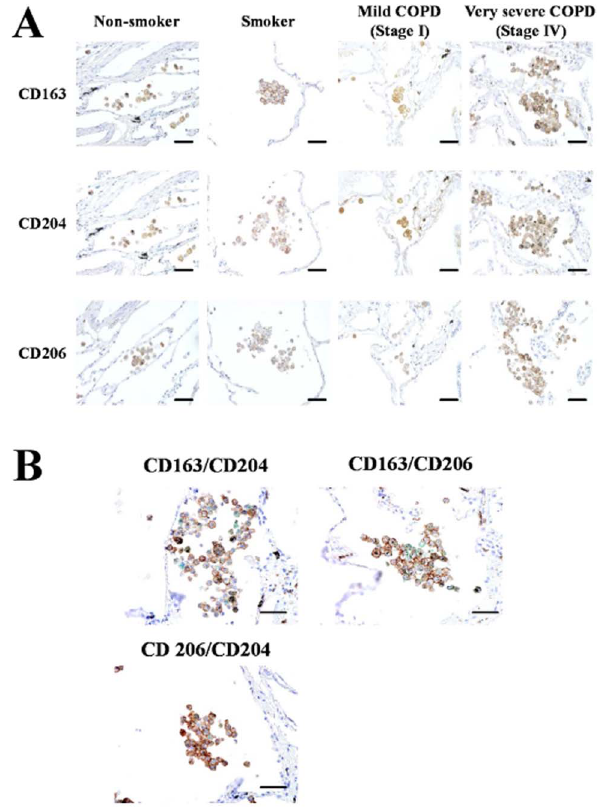
Figure 3. CD163, CD204 and CD206 immunohistochemical staining of lung tissue samples from a non-smoker, a smoker, a mild chronic obstructive pulmonary disease patient (COPD), and a very severe COPD. (A) Positive reactivity was identified by 3– 3 9 -diaminobenzidine-4HCl (DAB). Bar: 50 m m. (B) Double immunohisto- chemical analysis for CD163/CD204, CD163/CD206 and CD206/CD204. Lung tissues were obtained from a very severe COPD. CD163 (brown)/ CD204 (green), CD163 (brown)/CD206 (green) and CD206 (brown)/ CD204 (green) were double stained with DAB (brown) and HistoGreen (green), respectively. Bar: 50 m m.